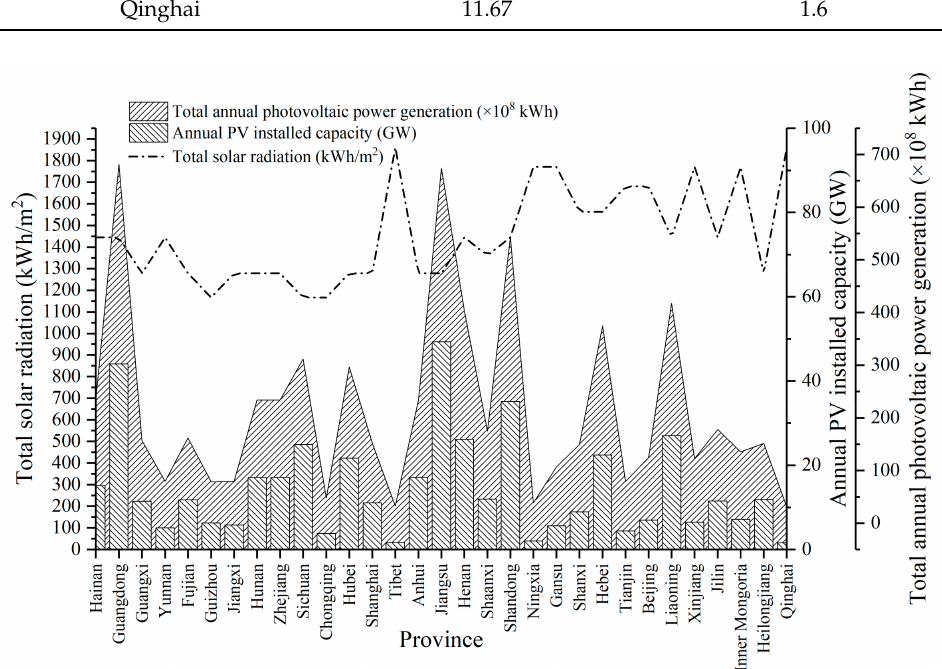
Figure 10. Photovoltaic power generation in cities in different provinces in